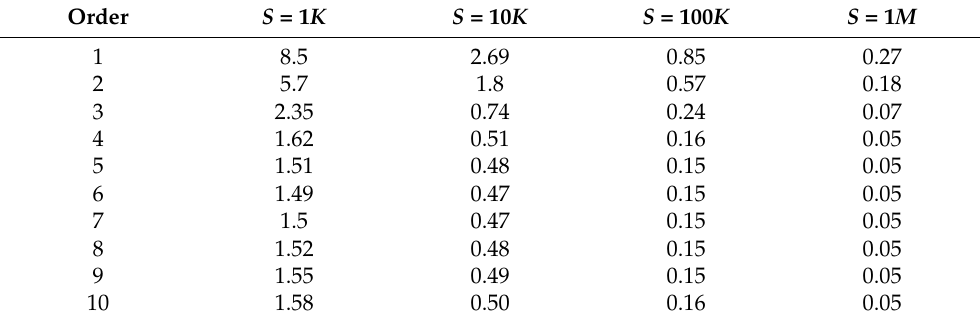
Table 2. Convergence errors in the mean annual losses for the pre-catXL perspective (in Figure 5) for various occurrence loss orders M = 1,...,10 using Equation (18). The first column has the occurrence loss order. The second column provides the number of simulation years ( S = 1000 = 1 K and S = 10 6 = 1 M years of simulation). Order